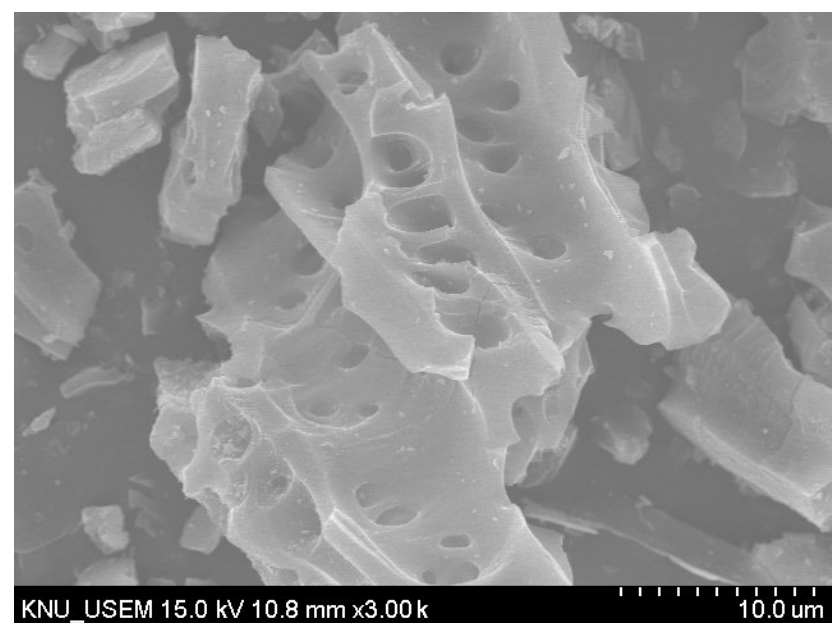
Figure 2. SEM image of biochar.